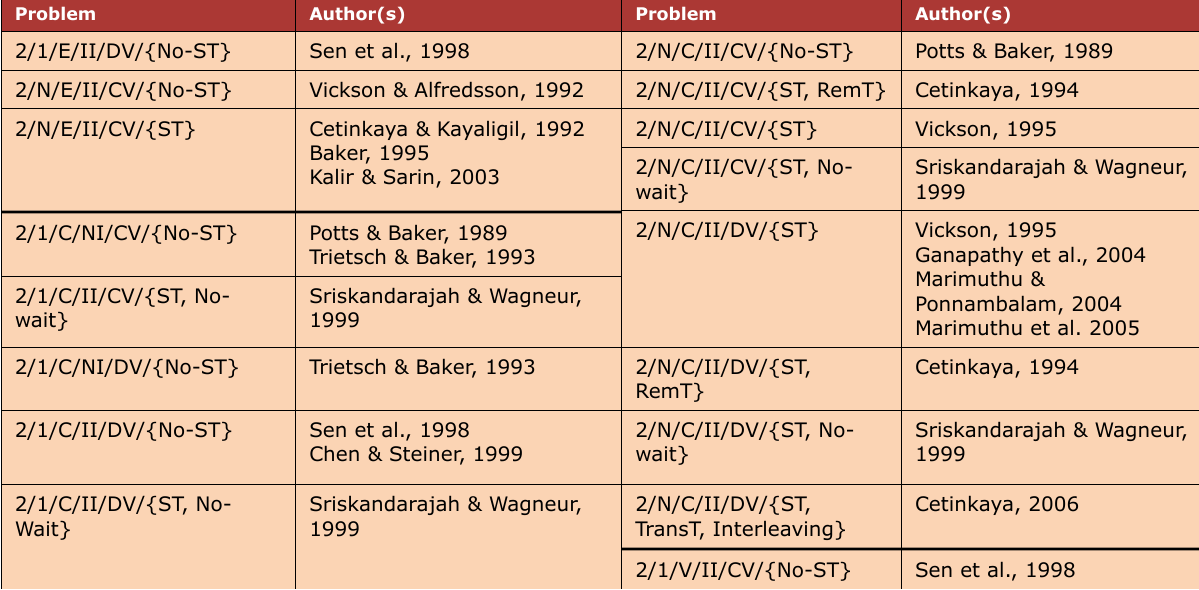
Table 1. Papers of two-stage flow